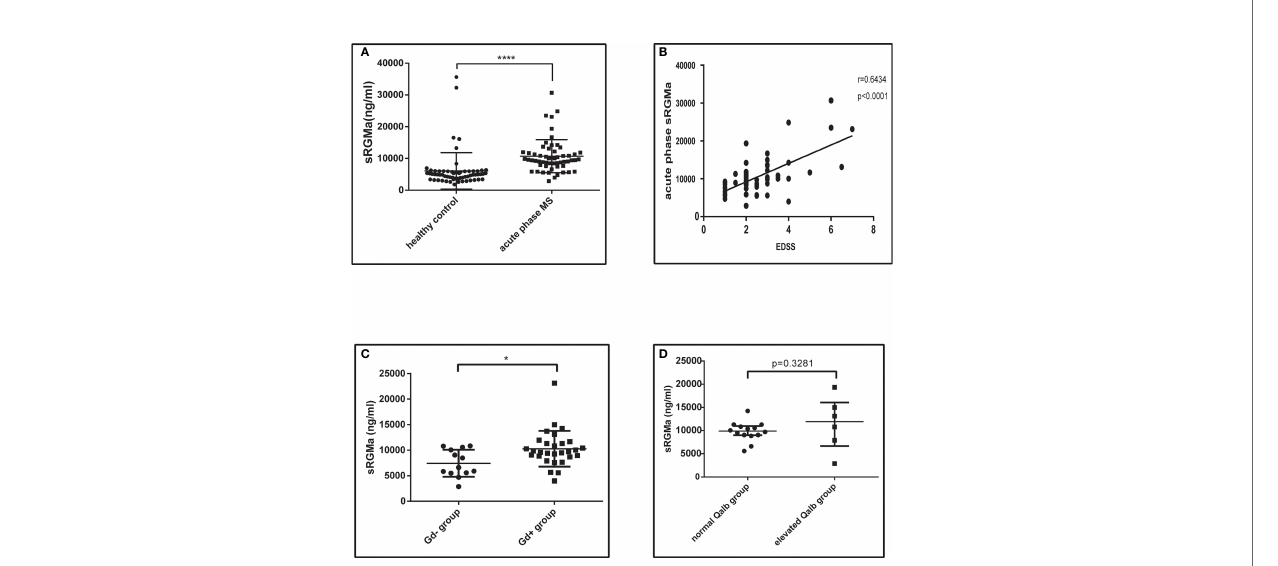
FIGURE 8 | Serum RGMa expression and correlation with BBB permeability in MS patients. (A) ELISA detected a signi fi cantly higher level of sRGMa expression in acute phase MS patients than in the HC group (10,706 ± 689.3 ng/ml vs. 6,081 ± 723.0 ng/ml, error bar: SD; **** p < 0.0001). (B) Pearson correlation coef fi cient showed a signi fi cant correlation between EDSS at admission and sRGMa in acute phase MS ( p < 0.0001, r 2 = 0.6434). (C) ELISA detected signi fi cantly higher levels of sRGMa expression in the Gd + group than in the Gd − group by (7,448 ± 734.5 ng/ml vs. 10,283 ± 650.6 ng/ml, error bar: SD; * p < 0.05). (D) ELISA detected a slightly increased level of sRGMa expression in the elevated Qalb group than in the normal Qalb group (9,883 [8,592, 10,993] vs. 11,956 [5,499, 17,517] ng/ml, median, 95% CI, p = 0.3281, Kolmogorov – Smirnov test).